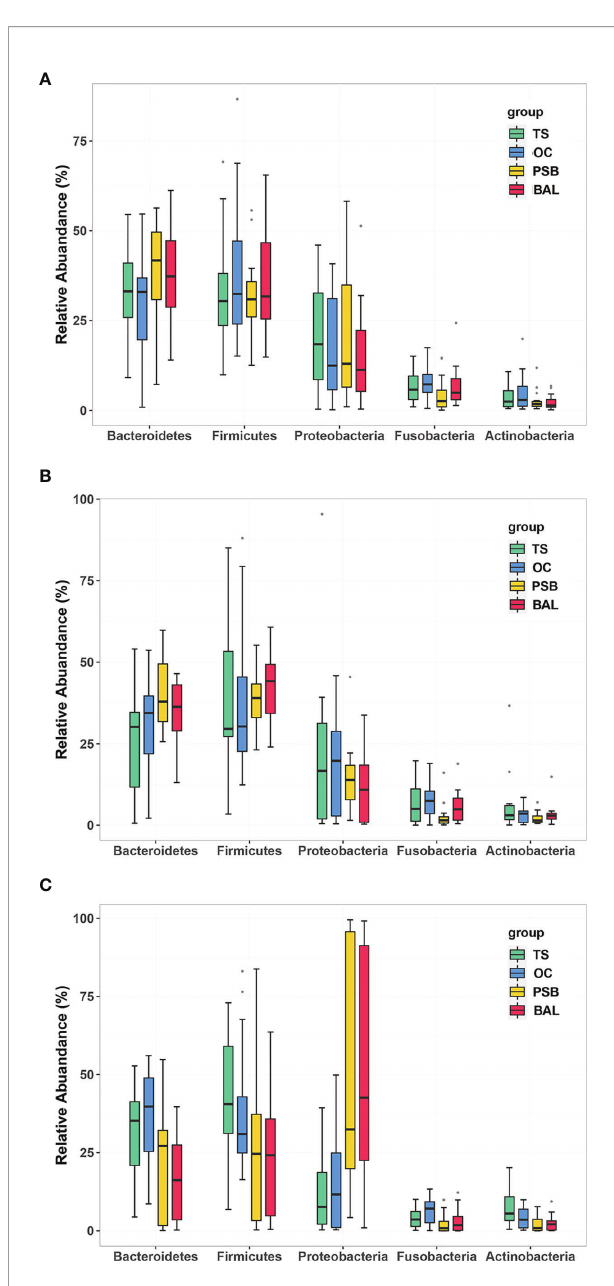
FIGURE 1 | Relative abundance of phylum level OTUs at four distinct biogeographic sites for NMTT (A) , SGC (B) , and SCC (C) patients. Box plots show the relative abundance and signi fi cance of the most signi fi cant genera. The center point denotes the median. Points outside the whiskers represent outlier